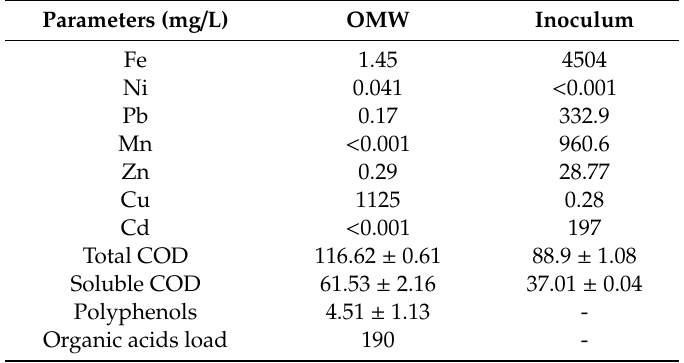
Table 2. Heavy metals concentration in the olive mill waste and in the inoculum, plus other